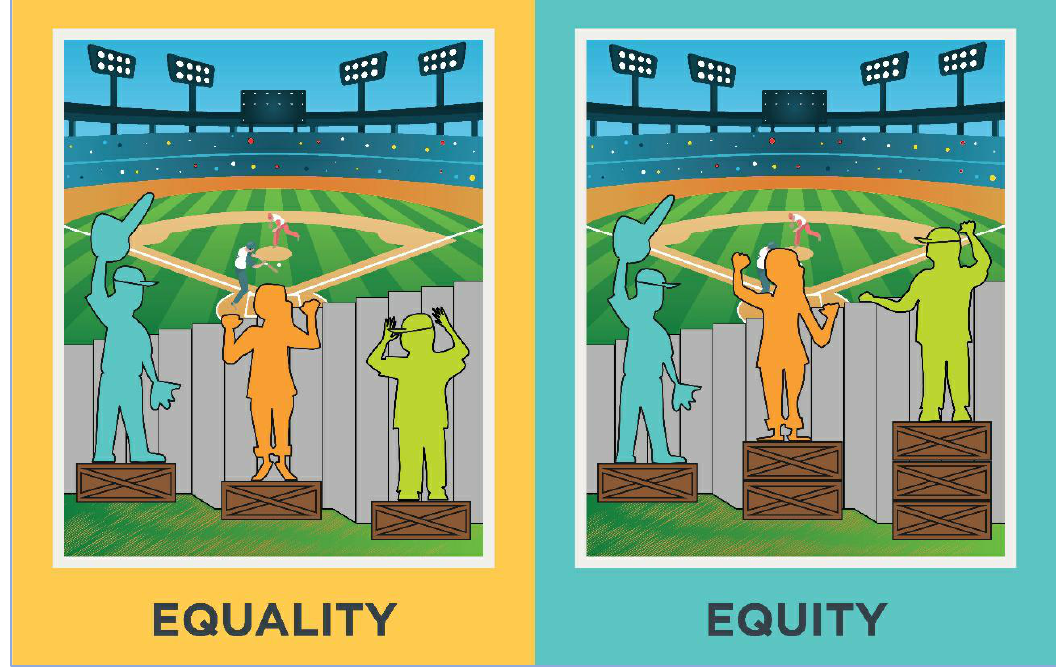
Figure 2. Equality vs. Equity Image. (Interaction Institute for Social Change, 2016; Fields, 2019; Kutner,